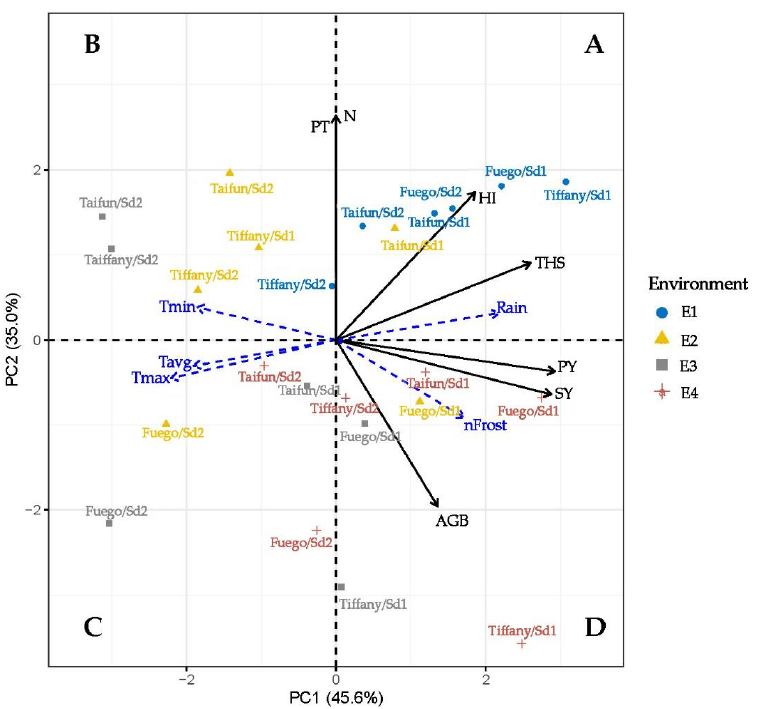
Figure 3. Principal component loading plots and scores of the first and second principal components after the PCA analysis on dry biomass (AGB), seed yield (SY), HI, 1000-seed weight (THS), protein content (PT), azote (N), and protein yield (PY) in faba beans as a function of the environment, culti- vars, and sowing dates. The square indicates a Pearson correlation coefficient of 1. The black arrows represent principal variables. Dotted blue arrows represent supplementary variables (weather pa- rameters). Tavg, average temperature; Tmax, maximum temperature; Tmin, minimum temperature; Rain, rainfall; nFrost, the number of days per month where the minimum temperature dropped below 0 ◦ C in winter. A, B, C, and D indicate upper-right, lower-right, upper-left, and lower-left quadrant,